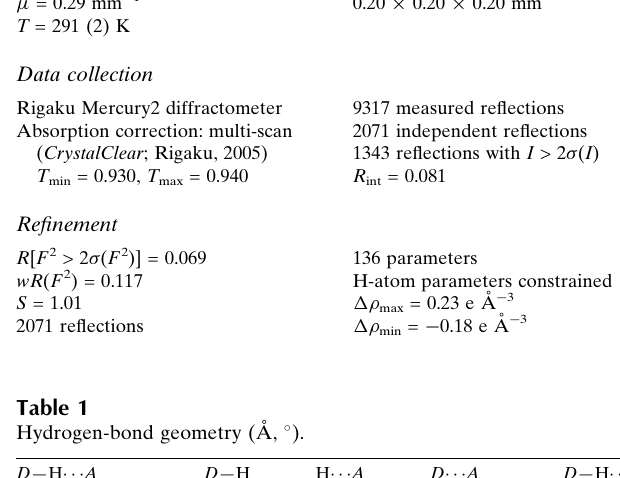
Rigaku Mercury2 diffractometer Absorption correction: multi-scan